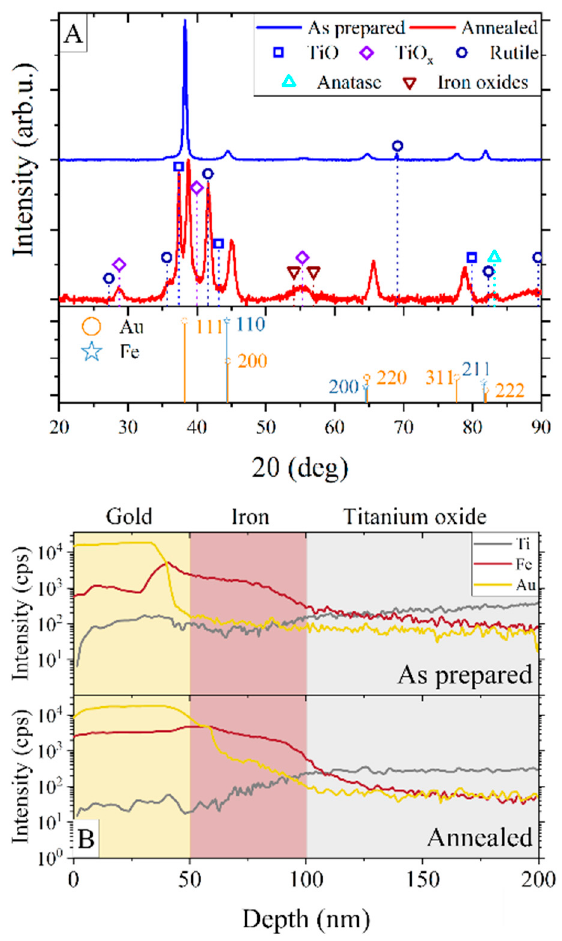
Figure 2. XRD patterns ( A ) and SNMS depth profiles ( B ) for as-prepared and annealed S20